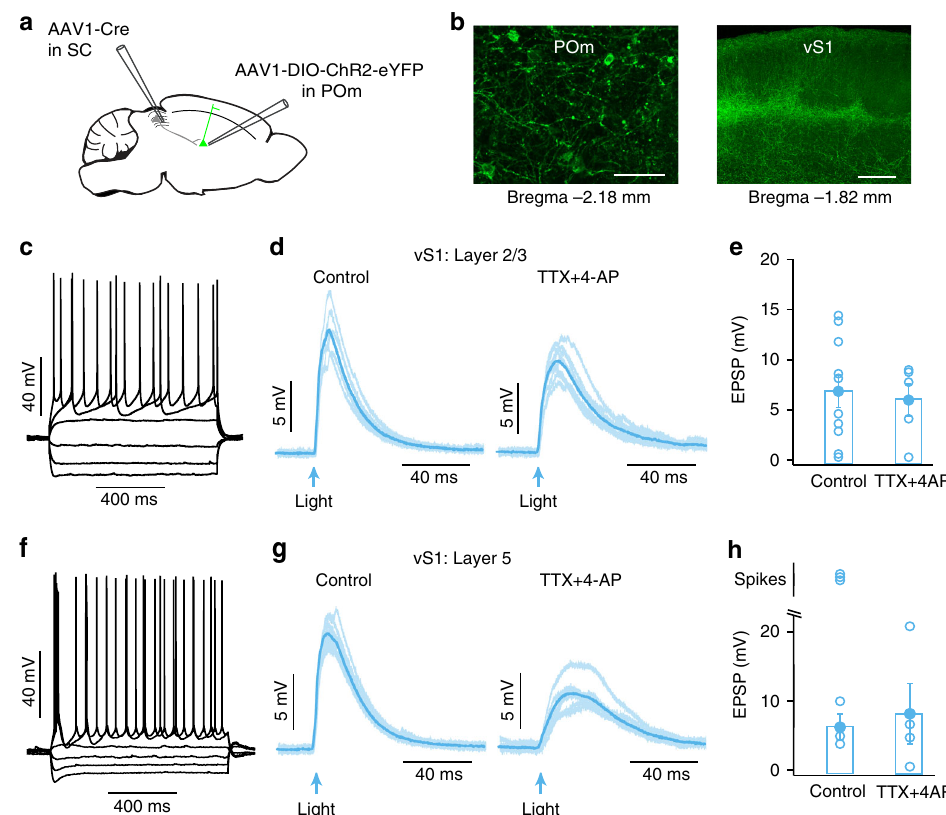
Fig. 6 SC is di-synaptically connected to vS1 through POm. a Schematic of the experimental paradigm for double viral injections. Expression of trans- synaptic Cre recombinase (AAV1.hSyn.Cre.WPRE.hGH) in SC was coupled with expression of Cre-dependent ChR2 (AAV1-Ef1a-DIO-hChR2(E123A)- eYFP) in POm. b eYFP expressing POm neurons (left: scale bar 50 µ m) send axons to vS1 (right; scale bar 250 µ m). c Response of a layer 2/3 vS1 neuron to somatic depolarizing and hyperpolarizing current injection ( − 400 pA to 250 pA). d Synaptic responses in the same neuron to optogenetic activation of POm axons (2 ms; 5 mW) in control (left) and in the presence of TTX and 4-AP (right). e EPSP amplitude in layer 2/3 vS1 neurons in control ( n = 10) and in the presence of TTX and 4-AP ( n = 5) during optogenetic activation of the axons of POm neurons receiving direct input from SC (2 ms; 5 mW). f Response of a layer 5 vS1 neuron to somatic depolarizing and hyperpolarizing current injection ( − 400 pA to 250 pA). g Synaptic responses in the same neuron to optogenetic activation of POm axons (2 ms; 5 mW) in control (left) and in the presence of TTX and 4-AP (right). h EPSP amplitude or spiking in layer 5 vS1 neurons in control ( n = 6) and in the presence of TTX and 4-AP ( n = 4) during optogenetic activation of the axons of POm neurons receiving direct input from SC (2 ms; 5 mW). Error bars represent SEM. Source data are provided as a Source Data fi spontaneous baseline activity of vS1 neurons in the absence of SC activation (Fig. 7d, orange at 0 µm; n = 23; p > 0.05 t -test).